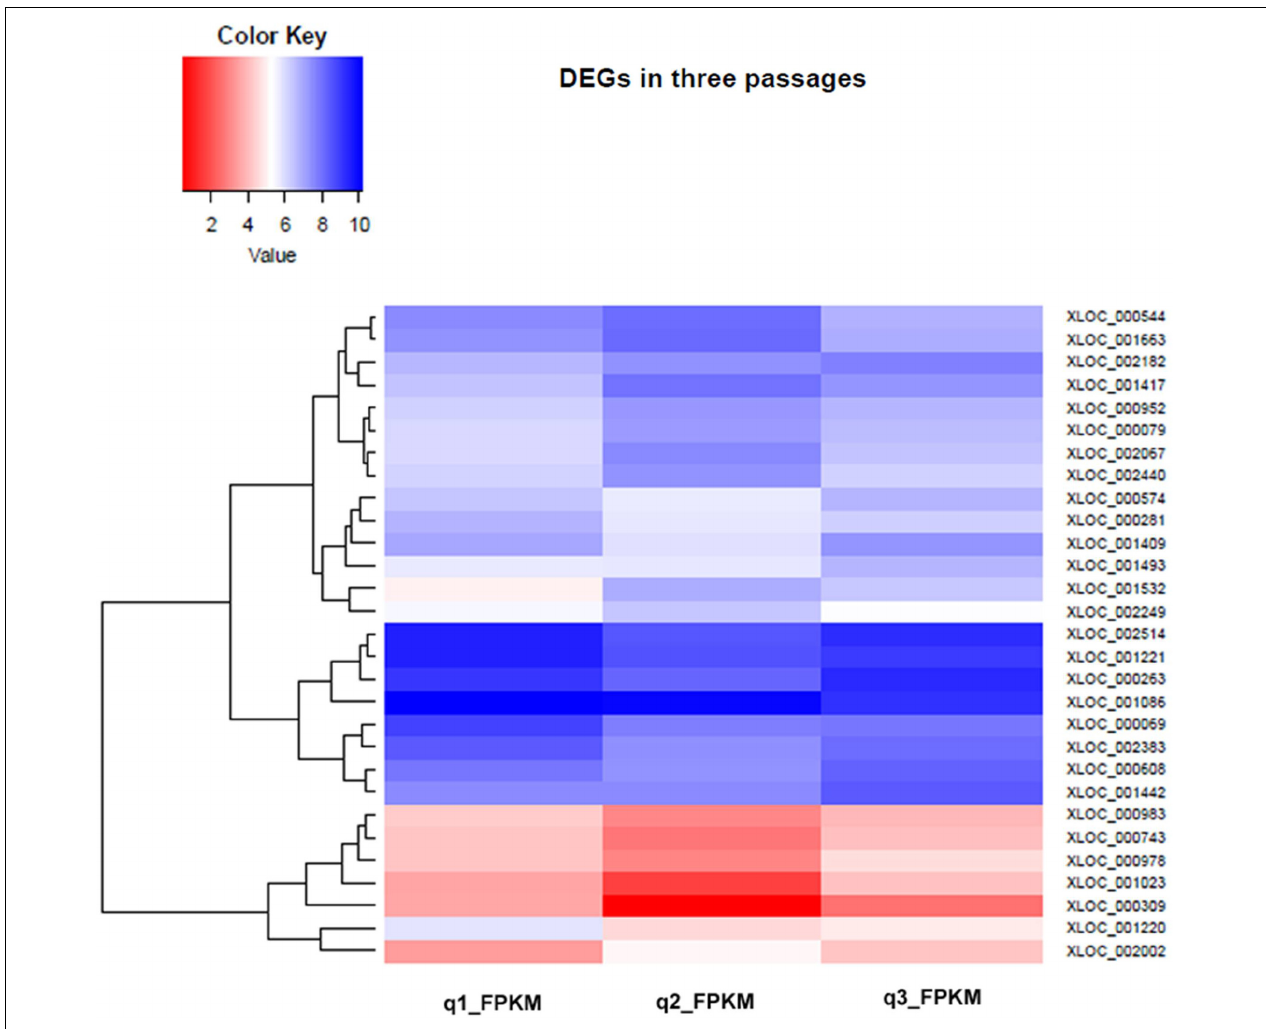
FIGURE 9 | Hierarchical Clustering Heatmap of differentially expressed genes in early, intermediate and late passages. Heat maps were generated to show the comparative log 2 abundance ratios between early, intermediate, and late passages using RNAseq data. Upregulated proteins are depicted by blue bars, downregulated proteins by red